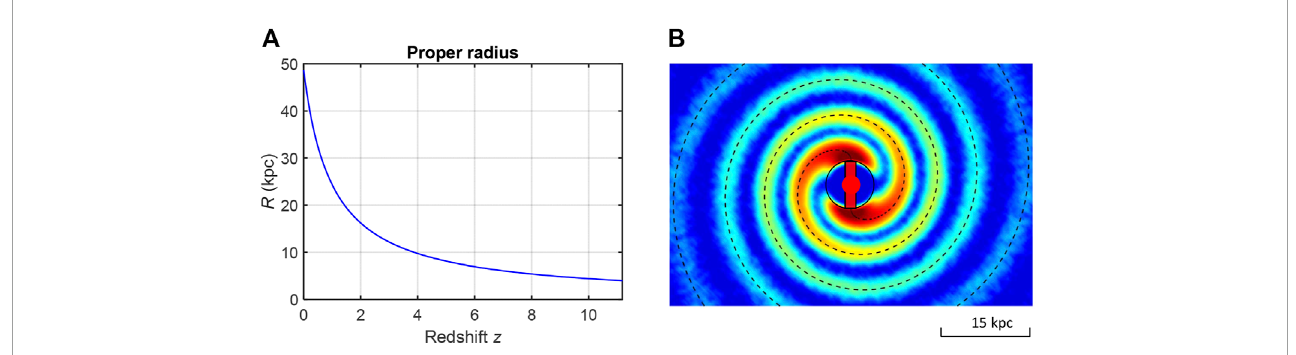
FIGURE 4 The proper radius of a galaxy as a function of redshift (A) , and the spiral arms formed during the galaxy evolution (B) . The density of the material in the spiral arms in (B) is colour coded. The age of the galaxy is 8.8 Gyr and the maximum redshift is z = 11 . 2. The solid black circle in (B) marks the boundary between the bulge-bar and spiral domains with radius R c = 4 kpc . The black dashed line in (B) denotes the central orbit with unperturbed parameters R c and ϕ . The other orbits forming the spirals are characterized by perturbed parameters R c and ϕ , see the text. The red bulge and bar inside the black circle in (B) illustrate schematically the orientation of the bar.